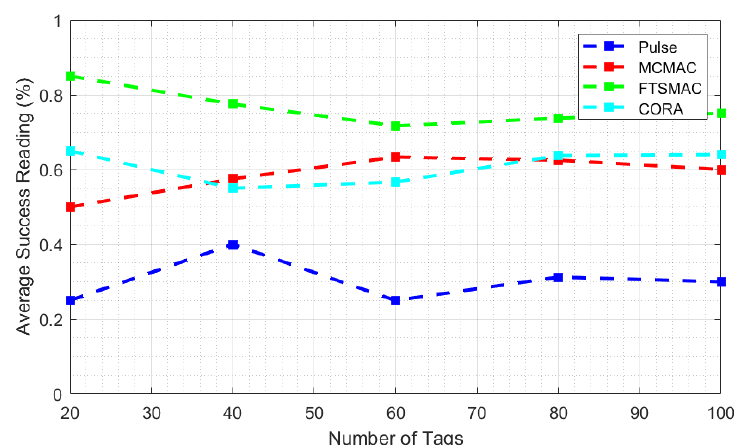
Figure 10. System performance vs. number of tags .